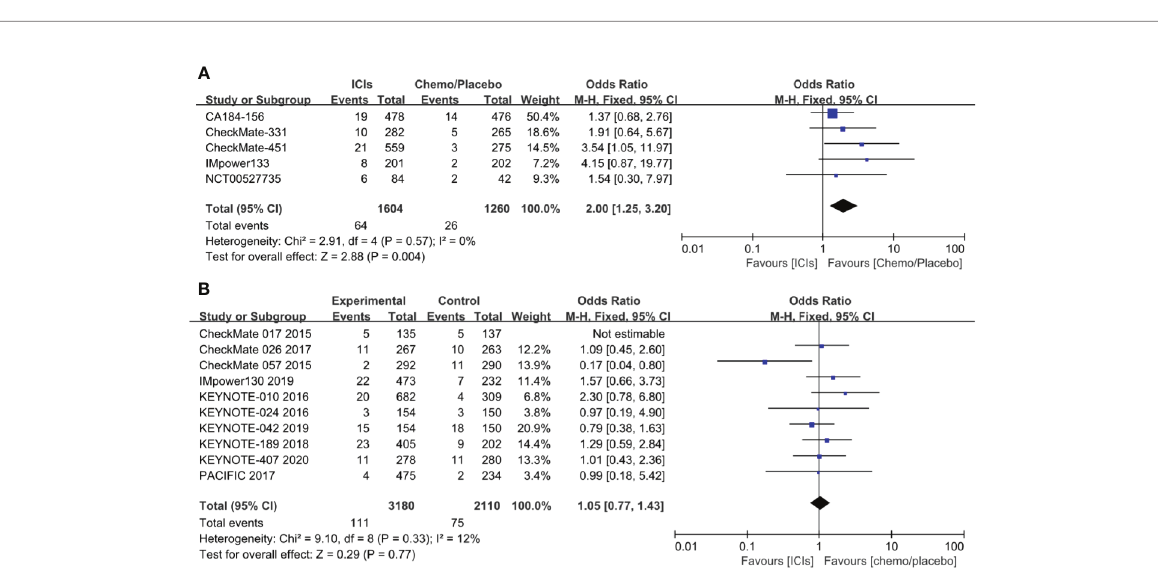
FIGURE 2 | List of common irAEs for different ICIs ( A : PD-1/PD-L1 inhibitors vs CTLA-4 inhibitors; B : PD-1 inhibitors vs PD-L1 inhibitors). Colored and black bar indicated the occurrence of irAEs of any grade and ≥ grade 3.